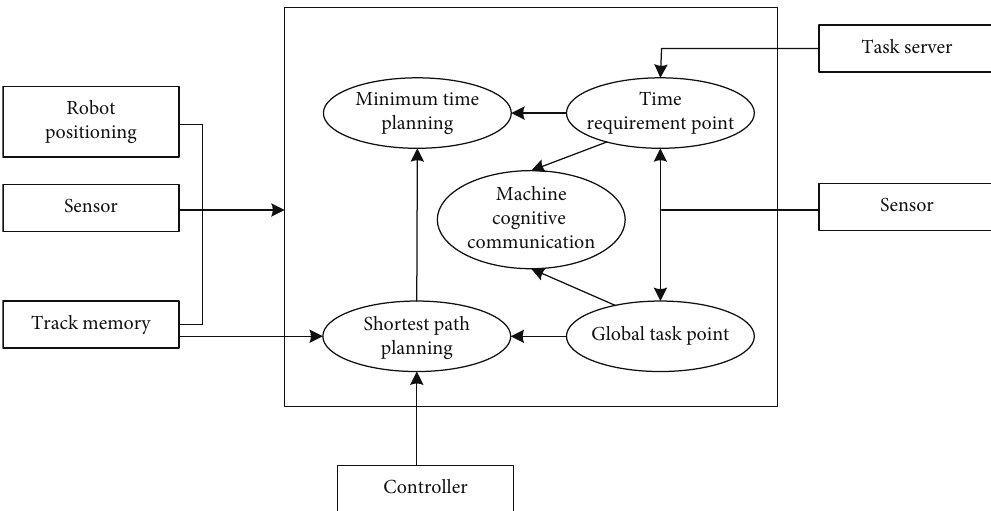
Figure 2: Multi-item optimization framework for the shortest path and shortest time of welding